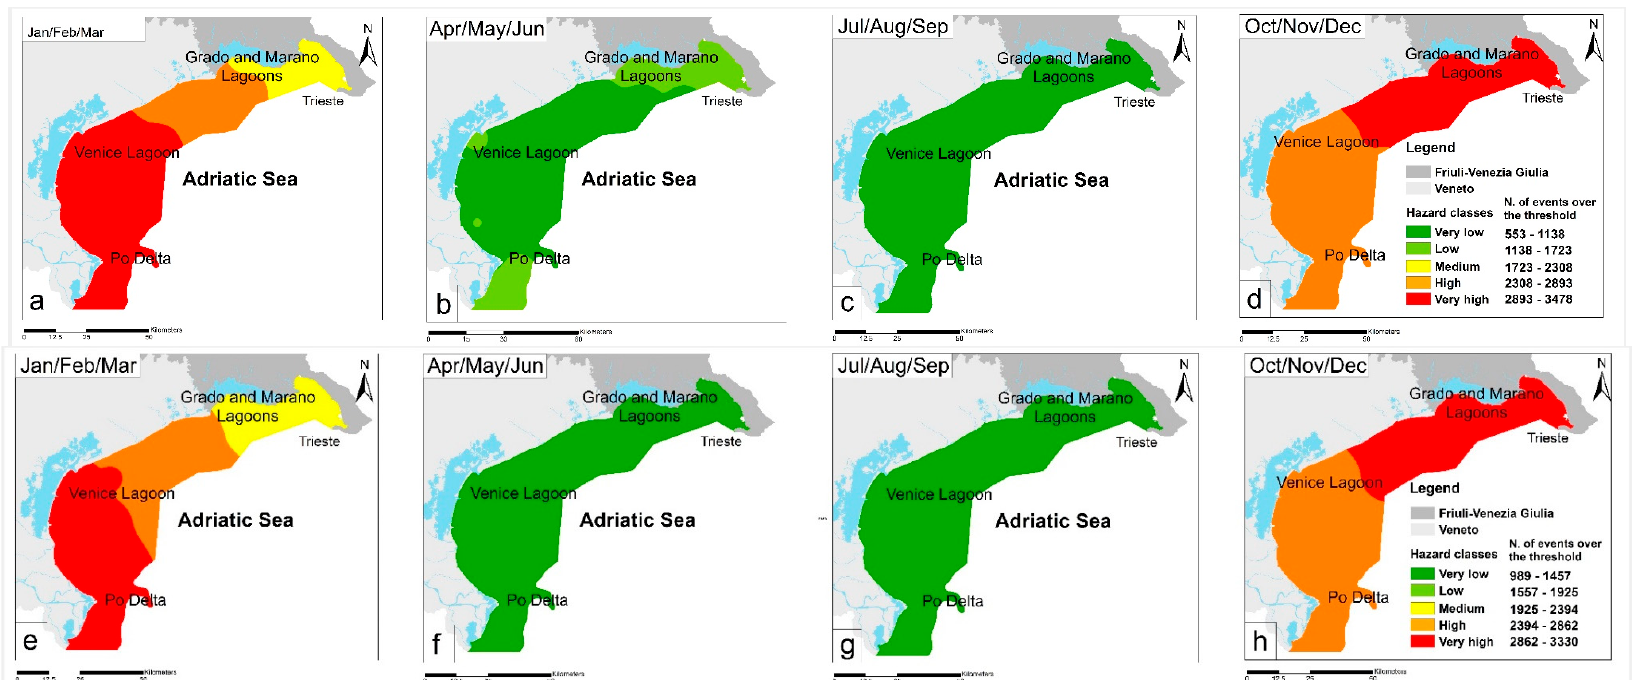
Figure 5. Hazard Maps representing the number of events exceeding the wave height ( a – d ) and bottom stress ( e – h ) thresholds (i.e., 0.97 m and 0.15 N/m 2 , respectively) as resulting from the coupled ROMS-SWAN system in the future scenario 2070 to 2100, for the four seasons: January/February/March, April/May/June, July/August/September, October/November/December.The spatial variance of bottom stress events in the four seasons for 2070 to 2100 shows that there is a decrease of hazard classes (i.e., from very high to medium) from south to north in winter (Figure 5e). Spring (Figure 5f) is mainly represented by the very low hazard class, except for few low hazard areas in the southern and northern zones of the NA. Finally, summer (Figure 5g) is interested by very low hazard class in the whole case study, while the autumn season (Figure 5h) is characterized by high hazard class in the southern area and very high hazard class in the northern